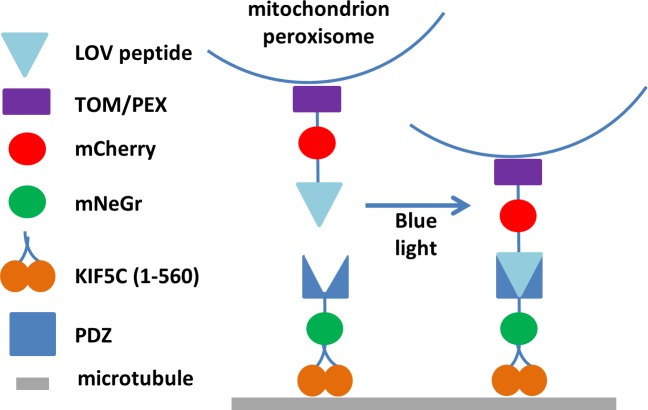
Construction of protein domains used in the optogenetic experiments.